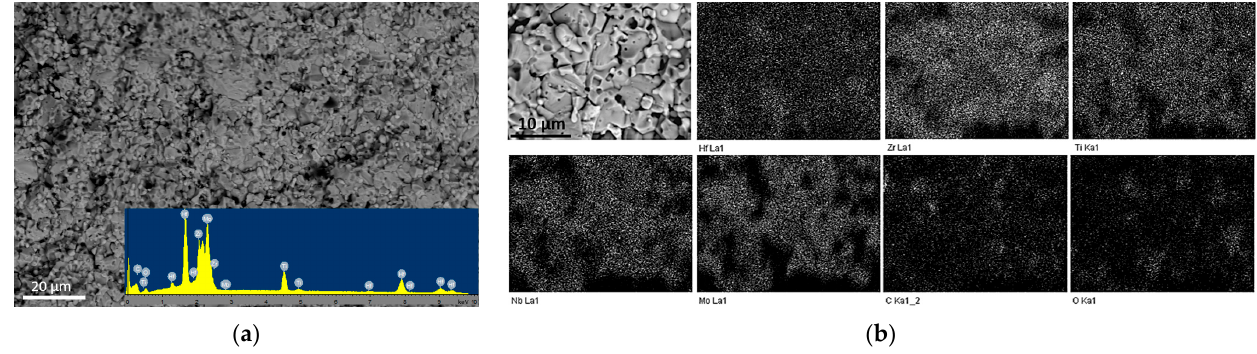
Figure 2. Fracture surface ( a ) and elemental mapping ( b ) of ceramics (Hf,Zr,Ti,Nb,Mo)C. The hardness of (Hf,Zr,Ti,Nb,Mo)C ceramic was found at 15 ± 0.8 GPa, compressive ultimate strength—at 1.6 ± 0.1 GPa and fracture toughness—at 4.4 ± 0.1 MPa·m 1/2 .